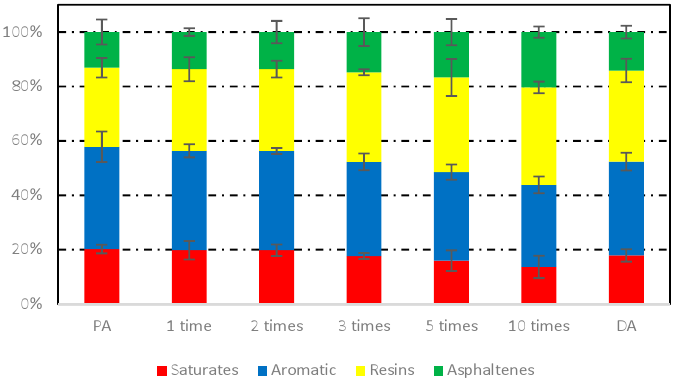
Figure 17. Component fractions of asphalt binders before and after induction heating in different conditions.